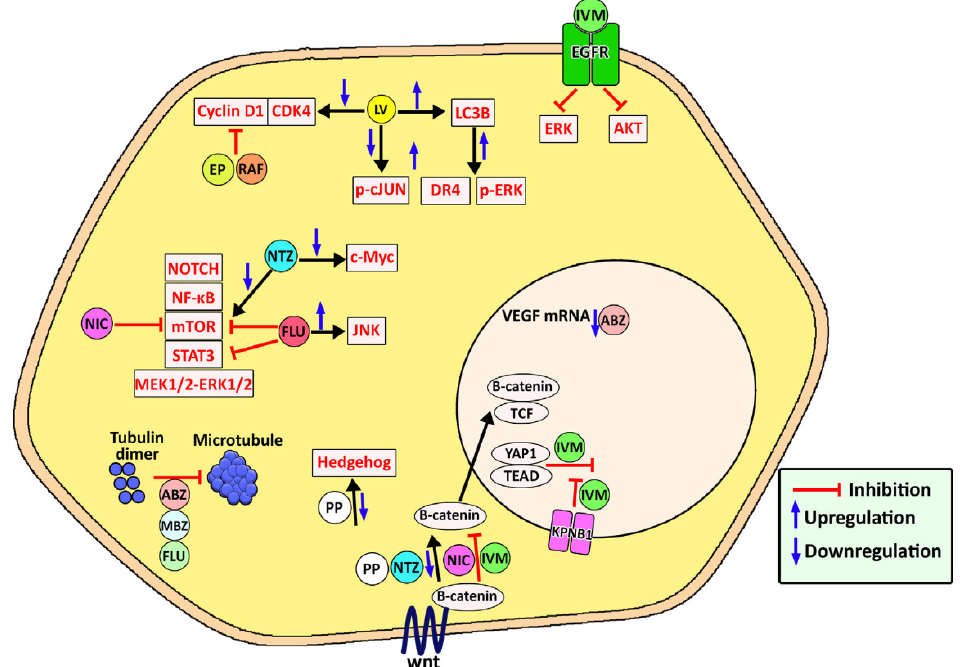
Figure 4. Mode of action used by various anthelmintics to exert their anticancer effects. The an- thelmintics work through the inhibition of tubulin polymerization to form microtubule, downregu- lation of Hedgehog signaling pathway, inhibition and downregulation of wnt/B-catenin pathway, and inhibition of Notch, NF- κ B, mTOR, STAT3, and MEK1/2-ERK1/2 signaling pathways; down- regulation of c-Myc signaling pathway; upregulation of JNK signaling pathway, inhibition and downregulation of cyclin D1-CDK4 pathway; downregulation of pc-jun pathway; upregulation of LC3B; upregulation of DR4 and p-ERK pathways, and inhibition of ERK and AKT. ABZ, albendazole; IVM, ivermectin; LV, levamisole; MBZ, mebendazole; NIC, niclosamide; FLU, flubendazole; RAF, Rafoxanide; NTZ, nitazoxanide; PP, pyrvinium pamoate; EP, eprinomectin; NF- κ B, nuclear factor kappa-light-chain-enhancer of activated B cells; mTOR, mammalian target of rapamycin; STAT3, sig- nal transducer and activator of transcription 3; JNK, c-Jun N-terminal kinase; CDK4, cyclin-dependent kinase 4; LC3B, microtubule-associated protein 1 light chain 3B; DR4, death receptor 4; p-ERK, phos- phorylated extracellular signal-regulated protein kinase; AKT, protein kinase B. Reproduced with permission from ref. [94]. Copyright 2021